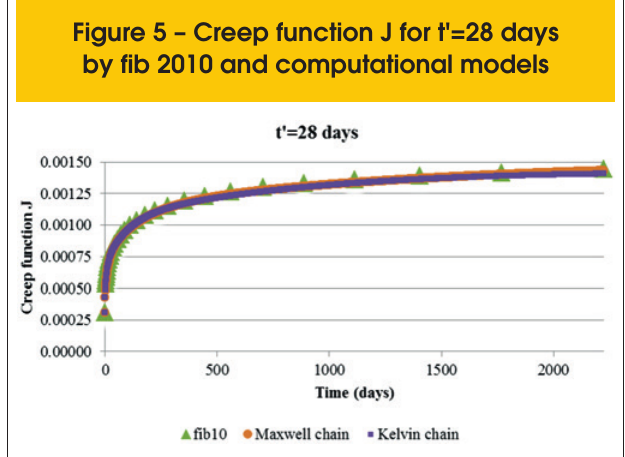
Figure 5 – Creep function J for t'=28 days by fib 2010 and computational models